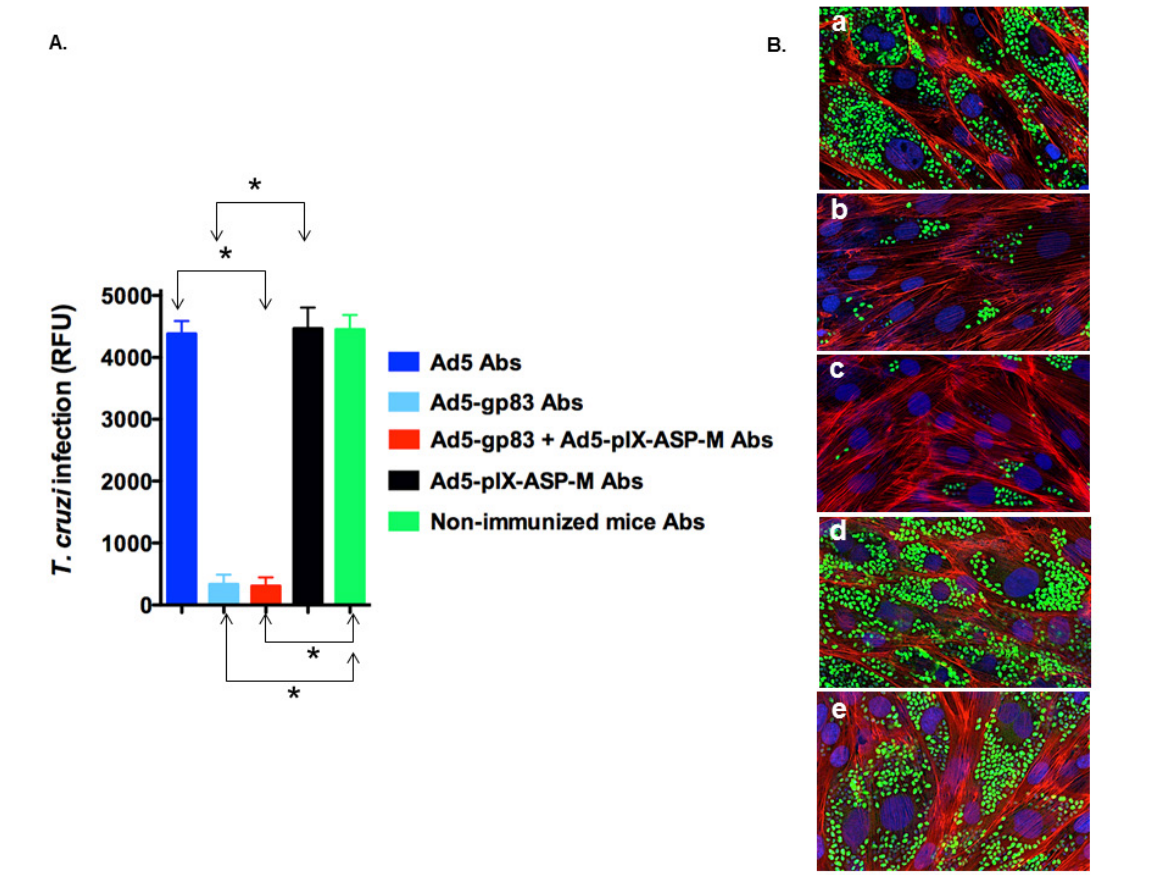
Figure 6. Mice co-immunized with Ad5-pIX-ASP-M and Ad5-gp83 induce neutralizing antibodies. (A): Neutralization of T. cruzi infection of cardiomyocytes with Abs from vaccinated mice with Ad5, Ad5-gp83, Ad5-gp83 + Ad5pIX-ASP-M, Ad5-pIX-ASP-M, or with Abs from nonimmunized mice. Para- site multiplication within cell monolayers was estimated by determining the fluorescence level of parasites expressing green fluorescence protein, which is indicated as relative fluorescence units (RFU) at 72 h of in- fection. Data represent the mean values ± SEM of results from triplicate samples. (*) = P < 0.0001 by 1-way ANOVA. (B): Fluorescence microscopic observation of the effect of neutralizing antibodies on cardiomyo- cyte infection by T. cruzi . Trypomastigotes expressing GFP were pre-treated with Abs from mice vaccinat- ed with Ad5 (a), Ad5-gp83 (b), Ad5-gp83 + Ad5-pIX-ASP-M (c), Ad5-pIX-ASP-M (d), or with Abs from nonimmunized mice (e) and exposed to cardiomyocytes for 72 h as described in Material and Methods. Abs were obtained from mice injected with either vaccine constructs or with Abs from nonimmunized mice before T. cruzi challenge. GFP-expressing amastigotes are seen inside host cells, host cell nuclei are stained blue, and cellular actin filaments are stained